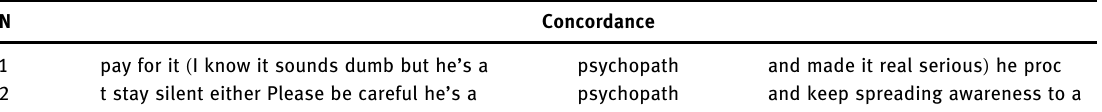
Table 16: Concordance lines for psychopath N